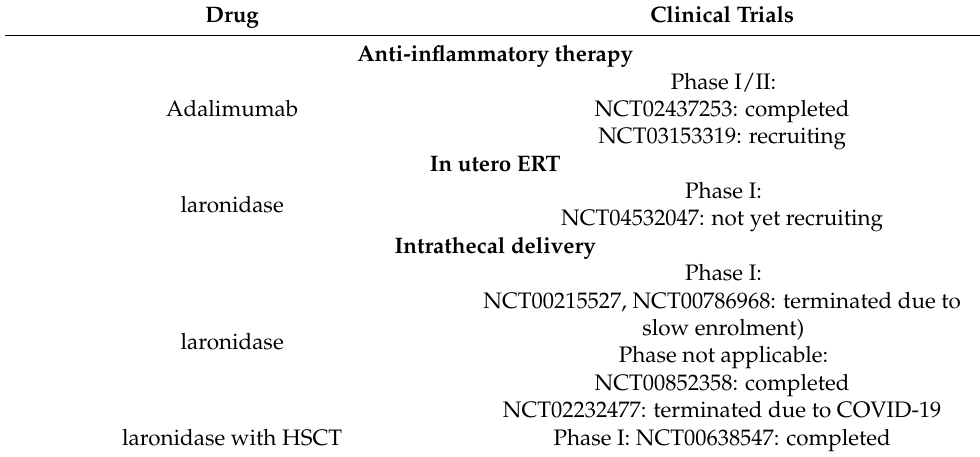
Table 2. Clinical Trials for MPS